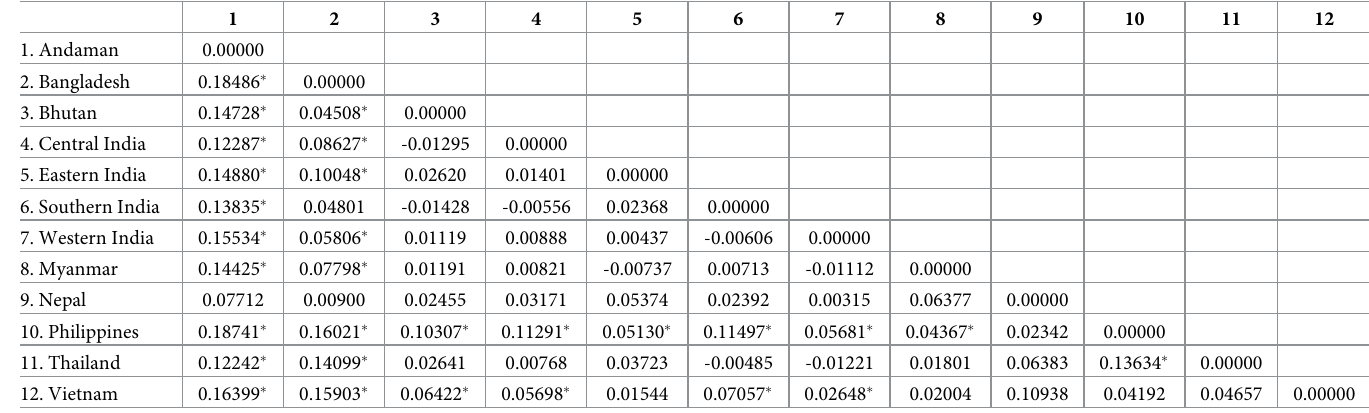
Table 1. Pairwise FST values of I1 cattle of Andaman and different regions of Indian subcontinent and Island Southeast Asian countries.